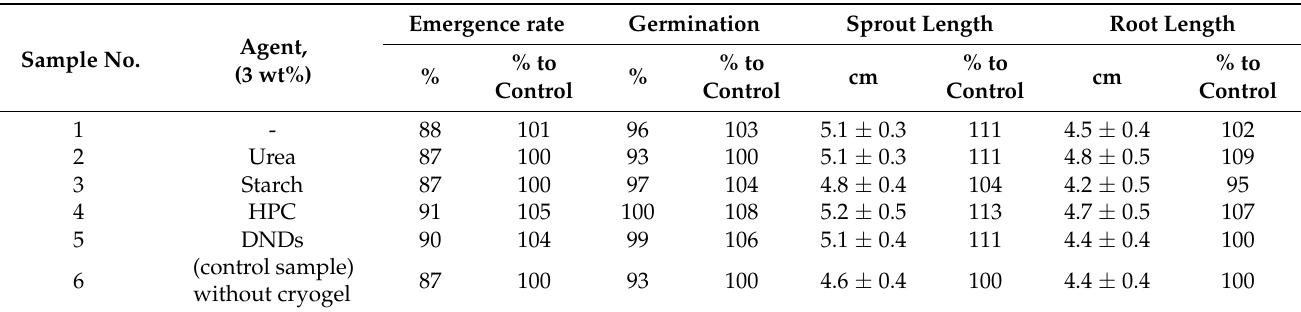
Table 2. Influence of hydrogel on sowing characteristics and growth rates of Lepidium sativum L. variety Ajur seedlings.